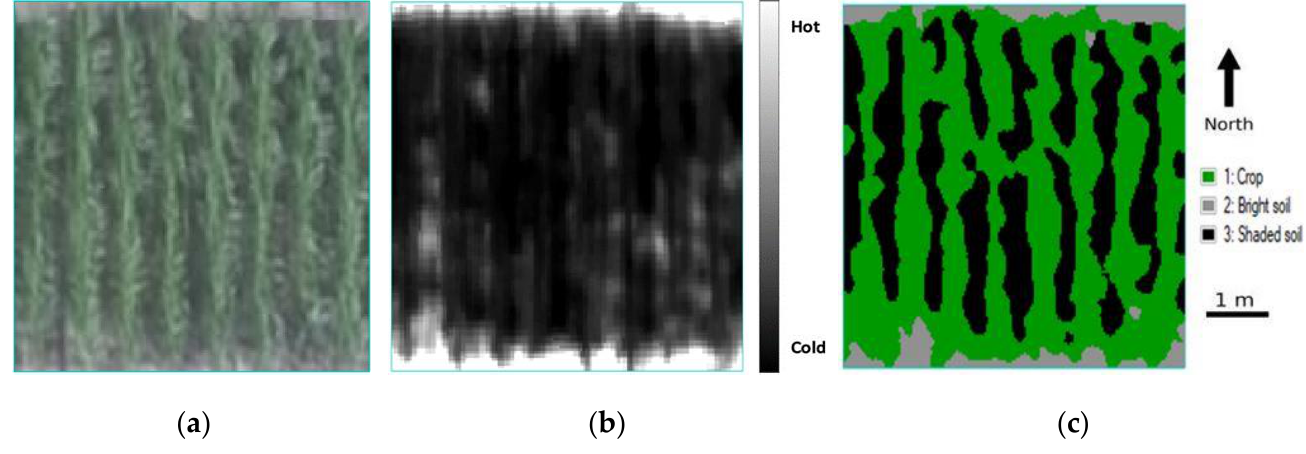
Figure 5. Supervised classification result of a plot in F54 north on 28 July 2020. ( a ) original RGB image; ( b ) thermal image (stretched for better visualization); ( c ) supervised classification result based on the RGB image. Table 1. Classification results. Confusion matrix for classification evaluation including producer and user accuracy of three classes: Crop, Sunlit Soil and Shaded Soil is of a plot in F54N on 28 July 2020. Ground